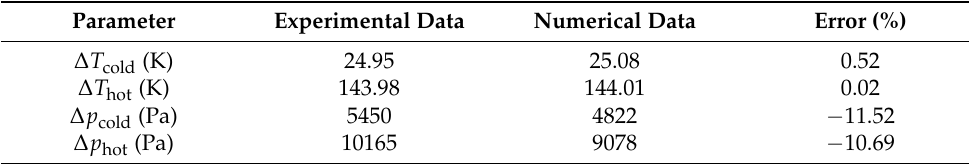
Table 3. Comparison between experimental and numerical